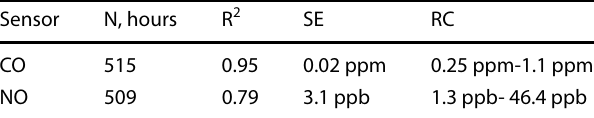
N represents the number of hours of calibration for each sensor in the AMS R 2 is the coefficient of determination SE is the standard error RC represents the range of the concentration during